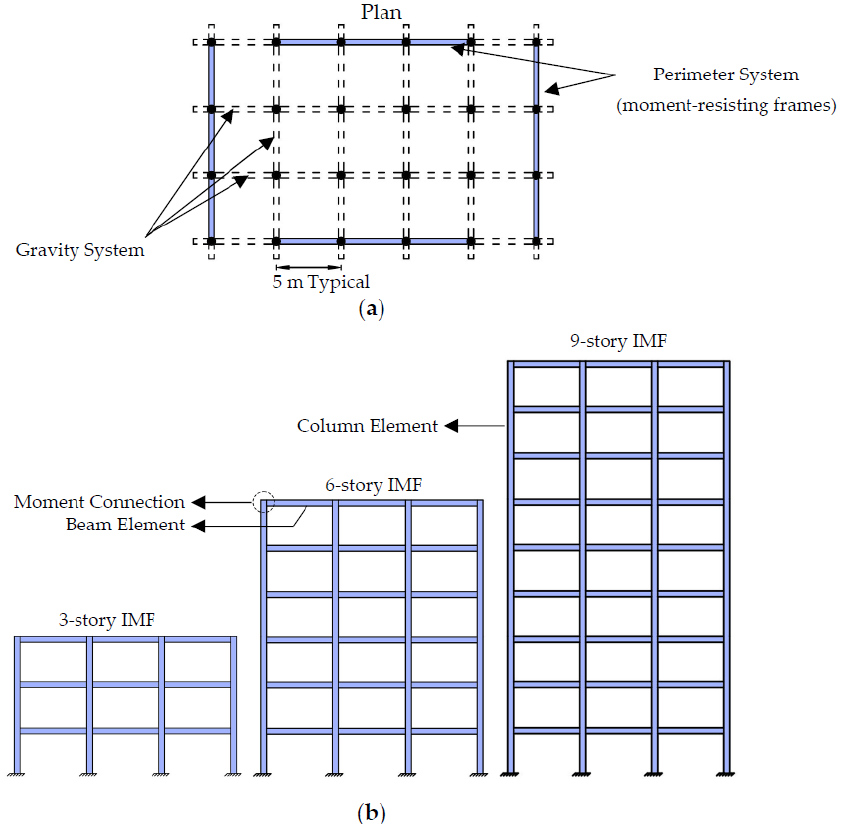
Figure 2. Configuration of models: ( a ) Typical Plan; ( b ) Elevation of structures.